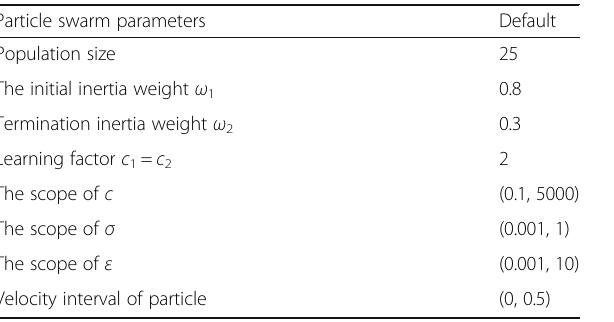
Table 7 The setting table of particle swarm parameters Particle swarm parameters